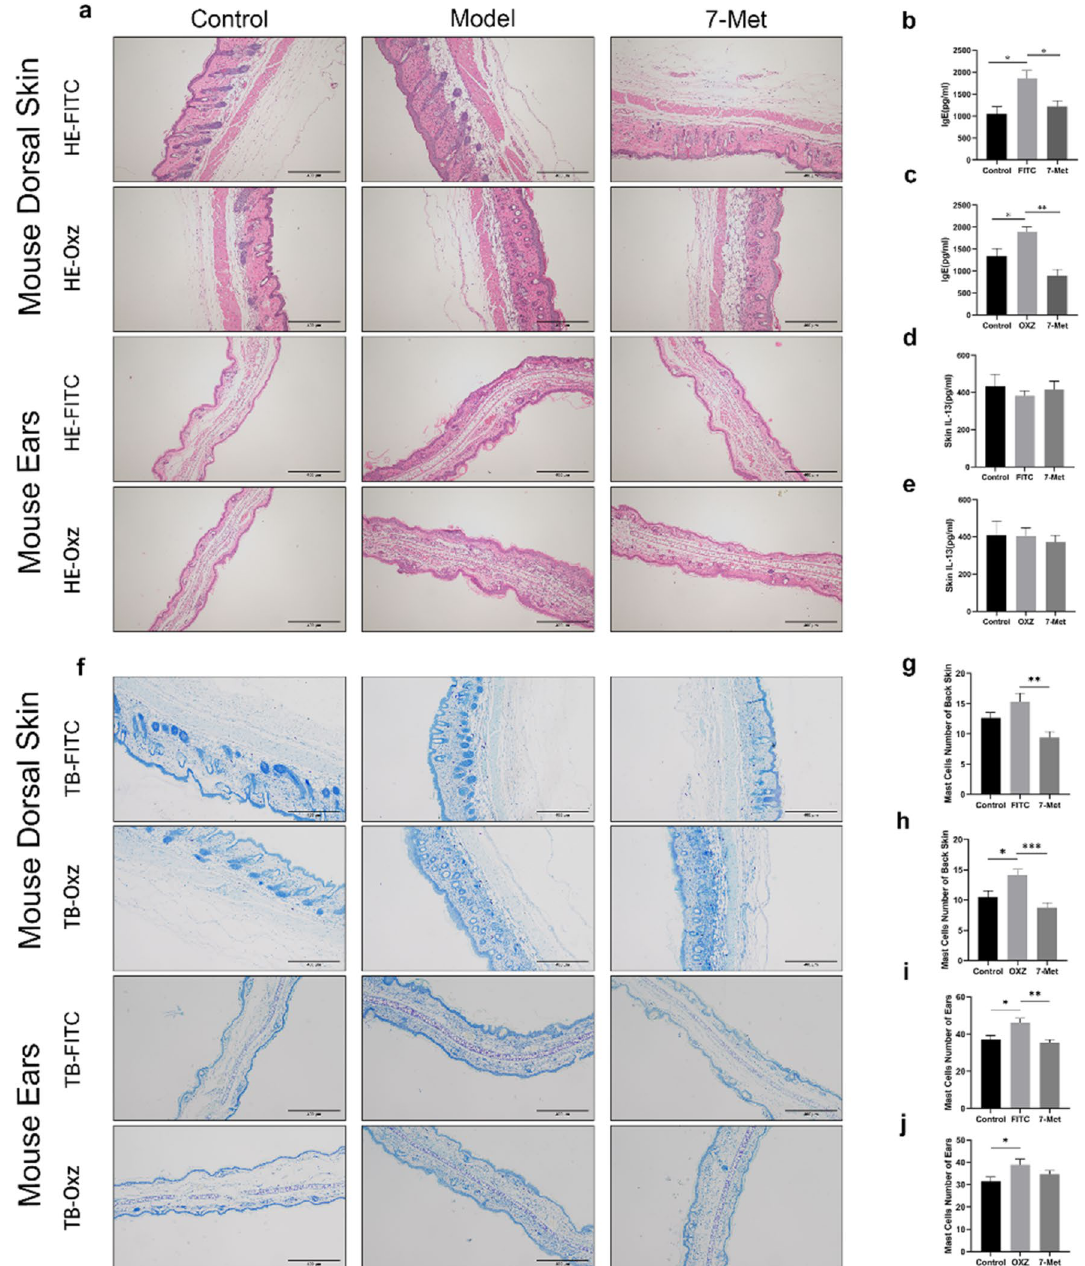
Figure 2. Histological analysis of AD mice. ( a ) Representative H&E-stained (scale bar = 400 μm) cross sections of ears and dorsal skin. ( b ) Total serum IgE level of FITC-model was measured by enzyme-linked immunosorbent assay (ELISA) (p Model = 0.0127, p 7-Met = 0.0159). Each bar represents the mean ± S.E.M. of ten independent experiments. ( c ) Total serum IgE level of OXZ-model was measured by enzyme-linked immunosorbent assay (ELISA) (p Model = 0.0367, p 7-Met = 0.0061). ( d ) Skin IL-13 level of FITC-model was measured by enzyme-linked immunosorbent assay (ELISA). ( e ) Skin IL-13 level of OXZ-model was measured by enzyme-linked immunosorbent assay (ELISA). ( f ) Representative TB-stained (scale bar = 200 μm) cross sections of ears and dorsal skin. ( g ) The number of mast cells in mouse dorsal skin treated by FITC or 7-Met was measured using ImageJ software. Values are expressed as the means ± S.E.M. (n = 3). (p 7-Met = 0.0011). ( h ) The number of mast cells in mouse dorsal skin treated by OXZ or 7-Met was measured using ImageJ software. Values are expressed as the means ± S.E.M. (n = 3). (p Model = 0.0201, p 7-Met = 0.0003). ( i ) The number of mast cells in mouse ears treated by FITC or 7-Met was measured using ImageJ software. Values are expressed as the means ± S.E.M. (n = 3). (p Model = 0.0108, p 7-Met = 0.0019). ( j ) The number of mast cells in mouse ears treated by OXZ or 7-Met was measured using ImageJ software. Values are expressed as the means ± S.E.M. (n = 3). (p Model = 0.0362) Each bar represents the mean ± S.E.M. of ten independent experiments. # p < 0.05, ## p < 0.01 VS FITC. *p < 0.05, **p < 0.01 VS OXZ. FITC fluorescein isothiocyanate, OXZ oxazolone,